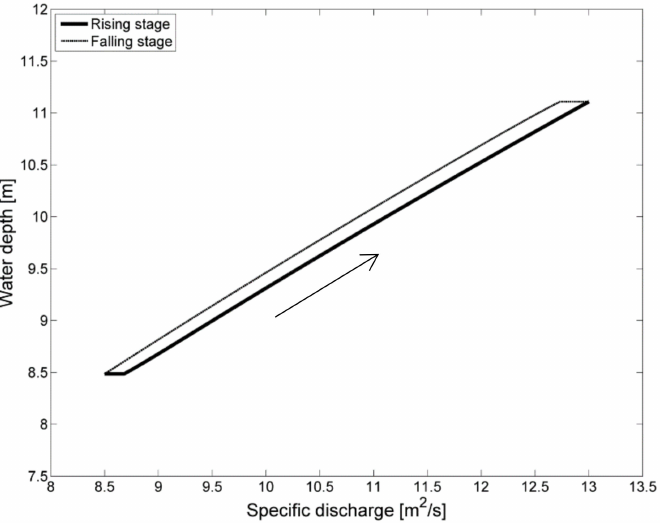
Figure 16. Specific discharge versus water depth separated for the rising and falling stages of the hydrograph, using the river scenario. The arrow signifies the direction of development over